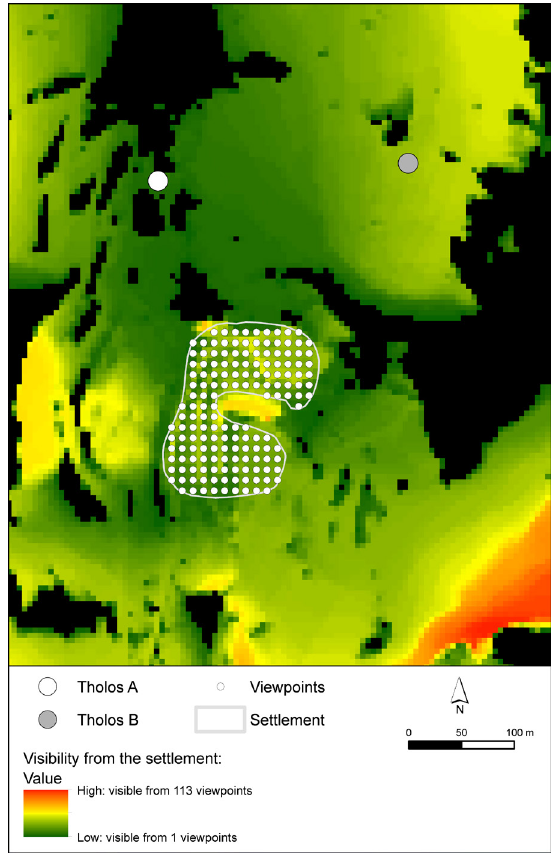
Figure 9. Cumulative viewshed (“view from”) calculated from 150 viewpoints distributed in the